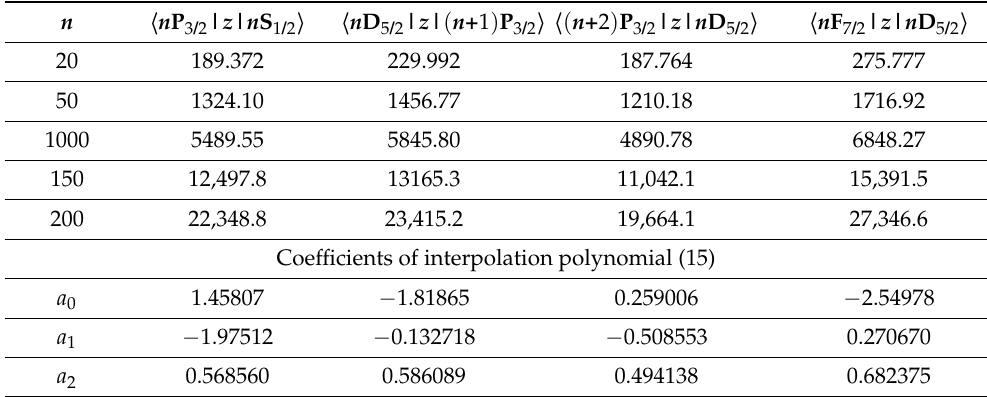
Table 9. The same as in Table 7, for K atoms. The corresponding transition frequencies are presented in Table 4.